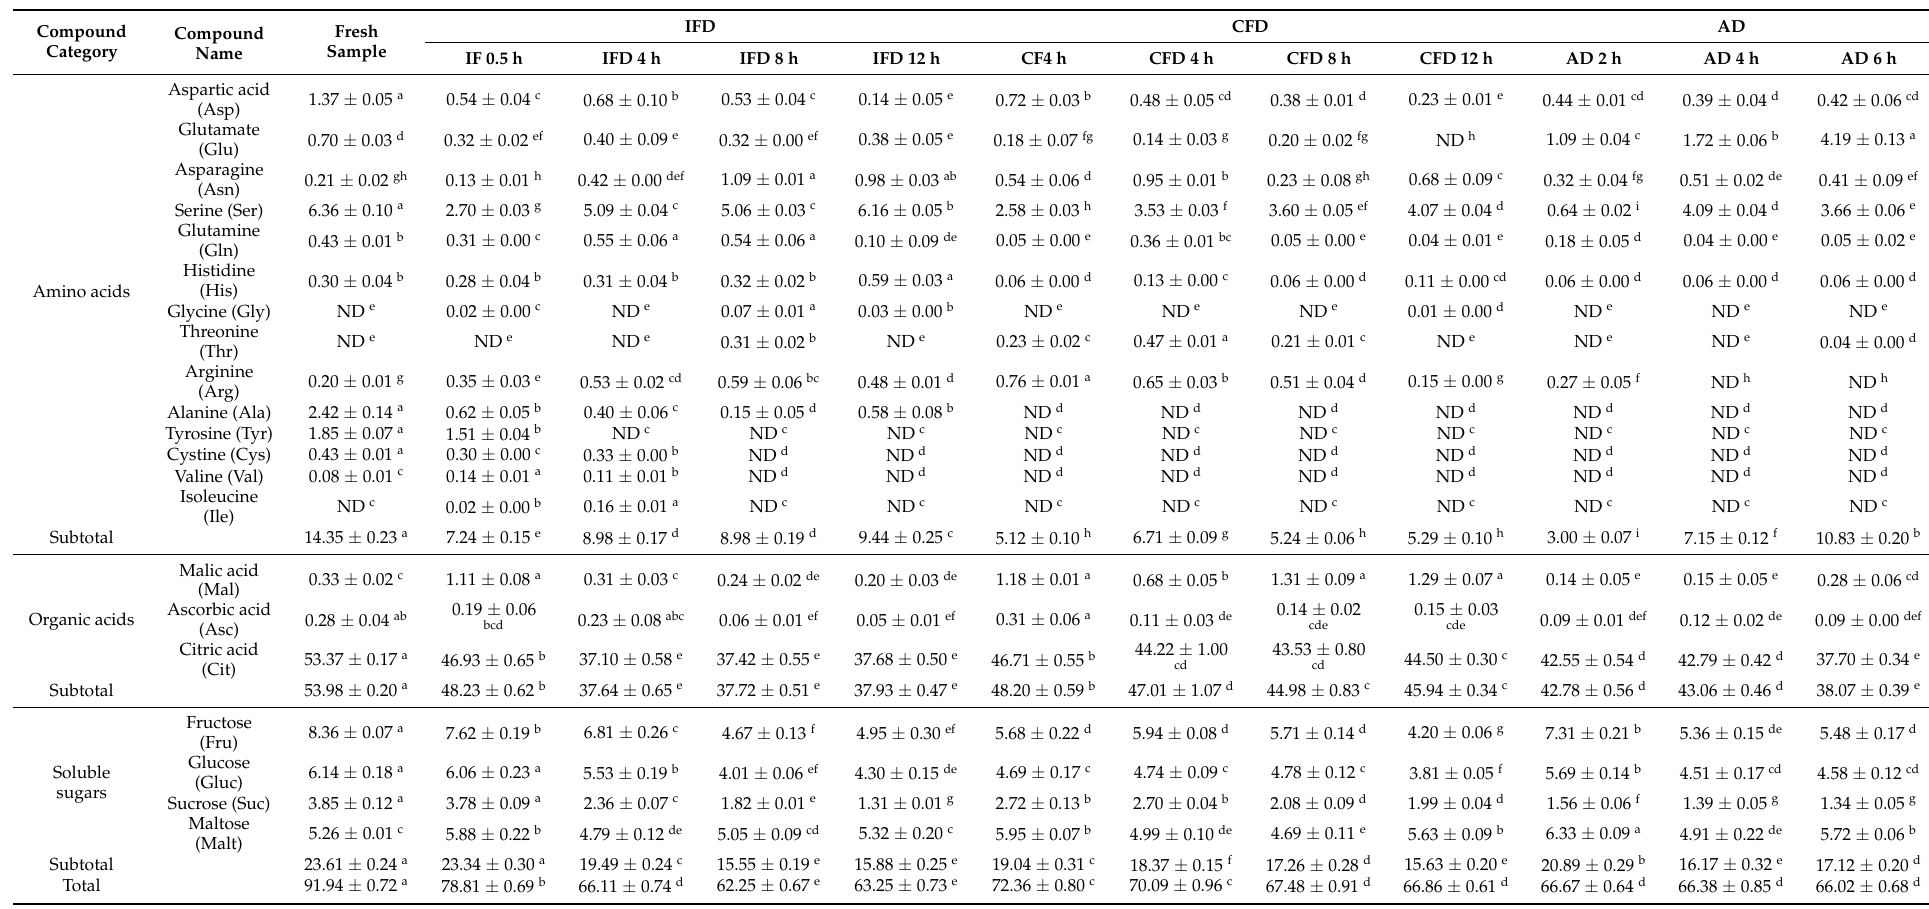
Table 2. Components and content of amino acids, organic acids, and soluble sugars of lemon juice vesicles through different drying methods/(mg/g